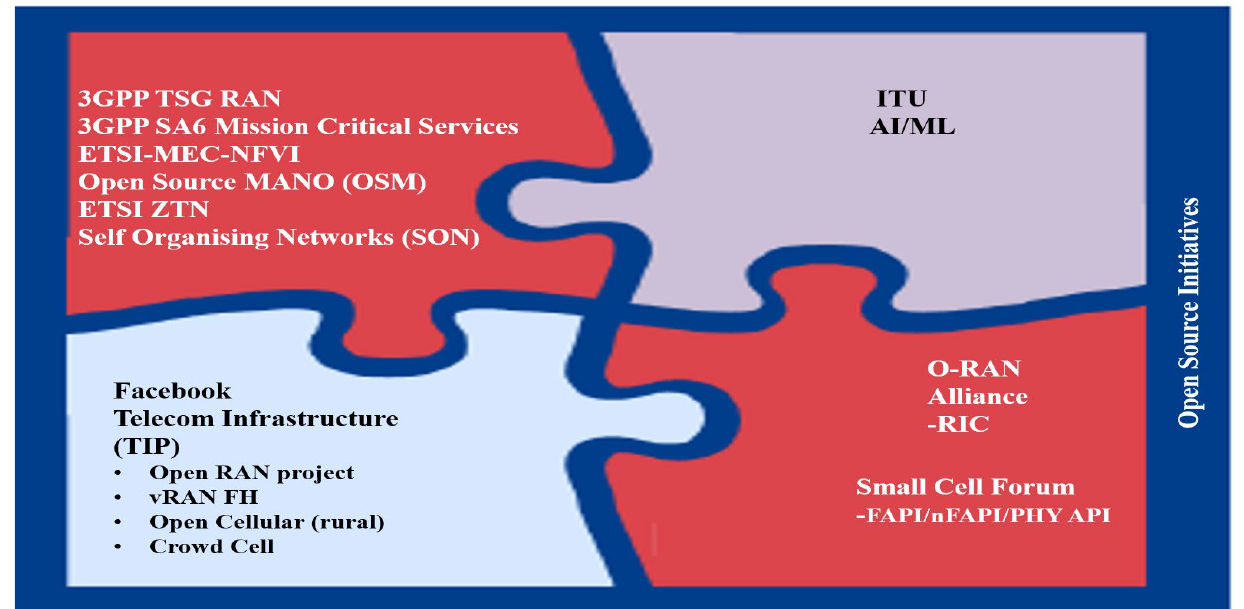
Figure 6. Standards and Open Source Initiatives for 5G Open